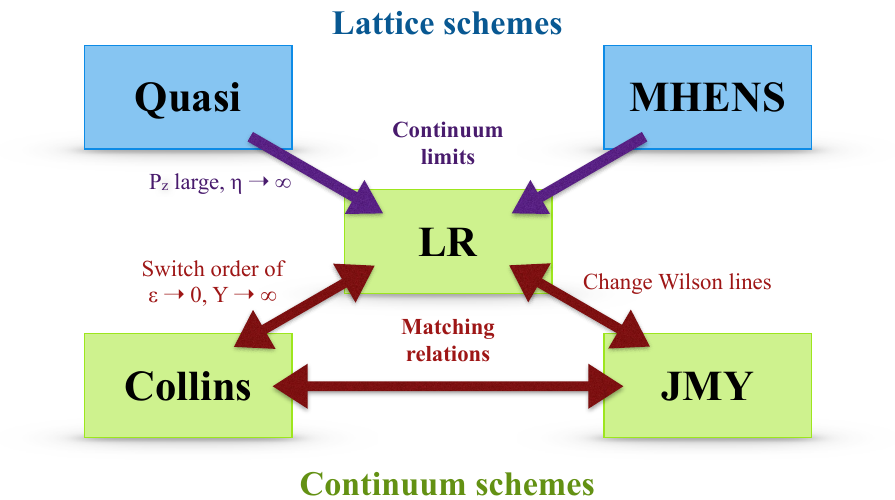
Figure 1 . An overview of schemes and their relationships, including the LR scheme introduced in this work. See section 3 for